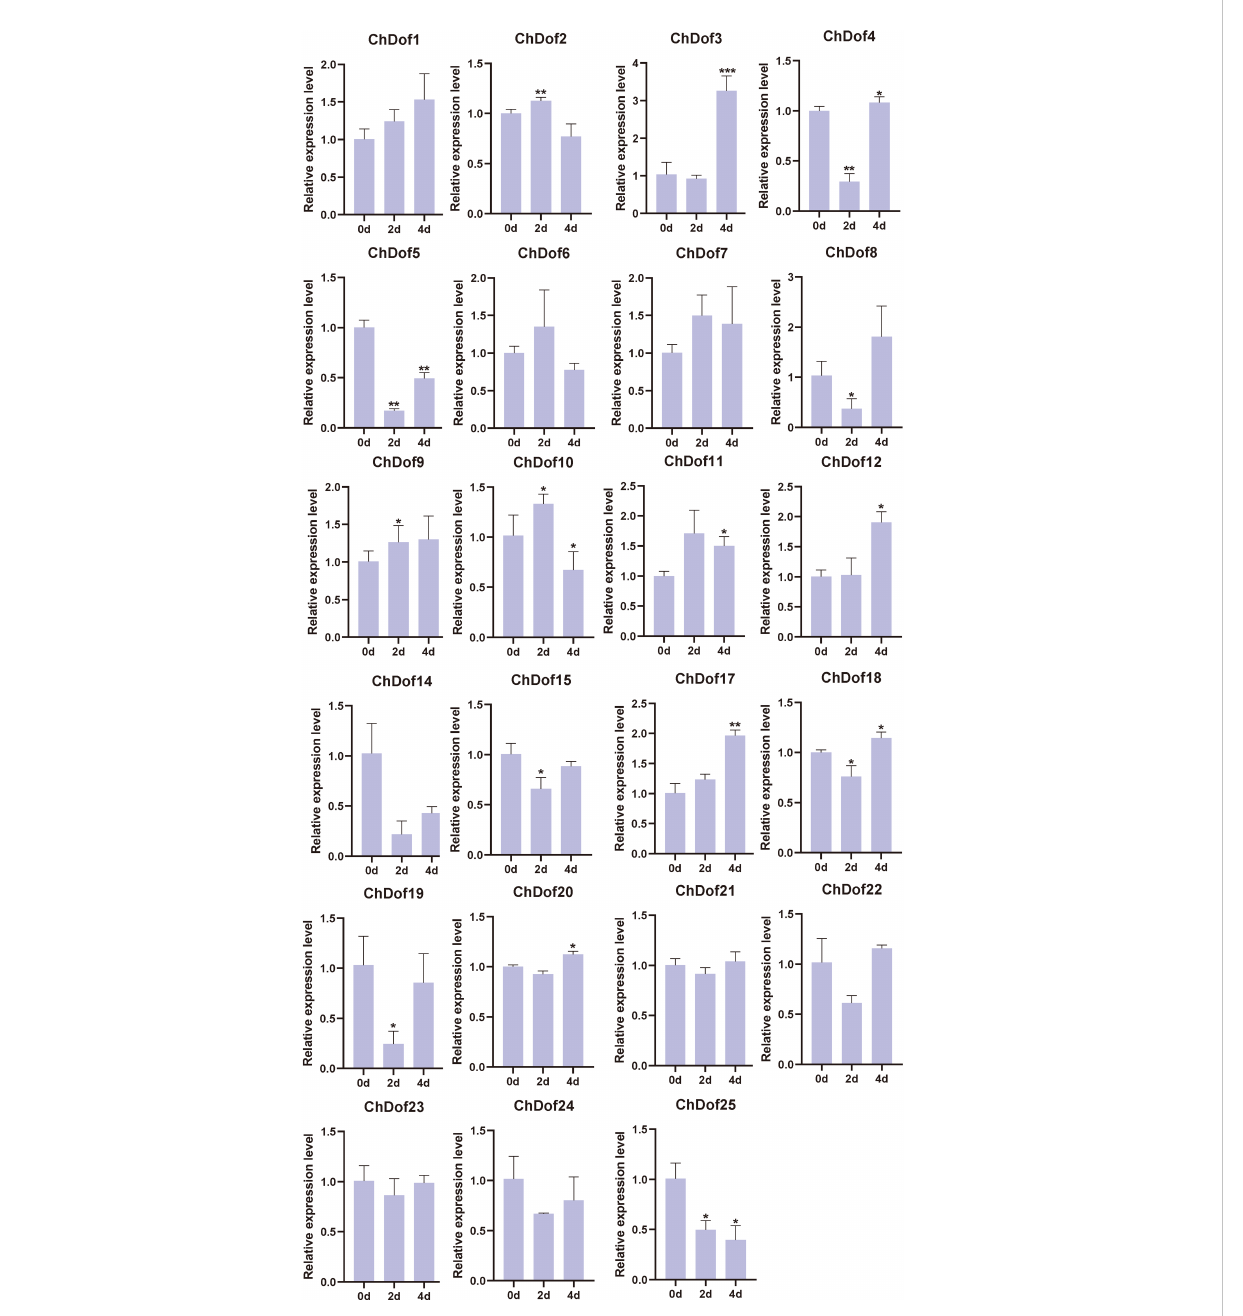
FIGURE 9 The qRT-PCR analysis of ChDofs in response to low-temperature storage. Asterisks indicate statistically signi fi cant differences compared with the 0d (Student ’ s t-test: *p < 0.05; **p < 0.01; ***p <